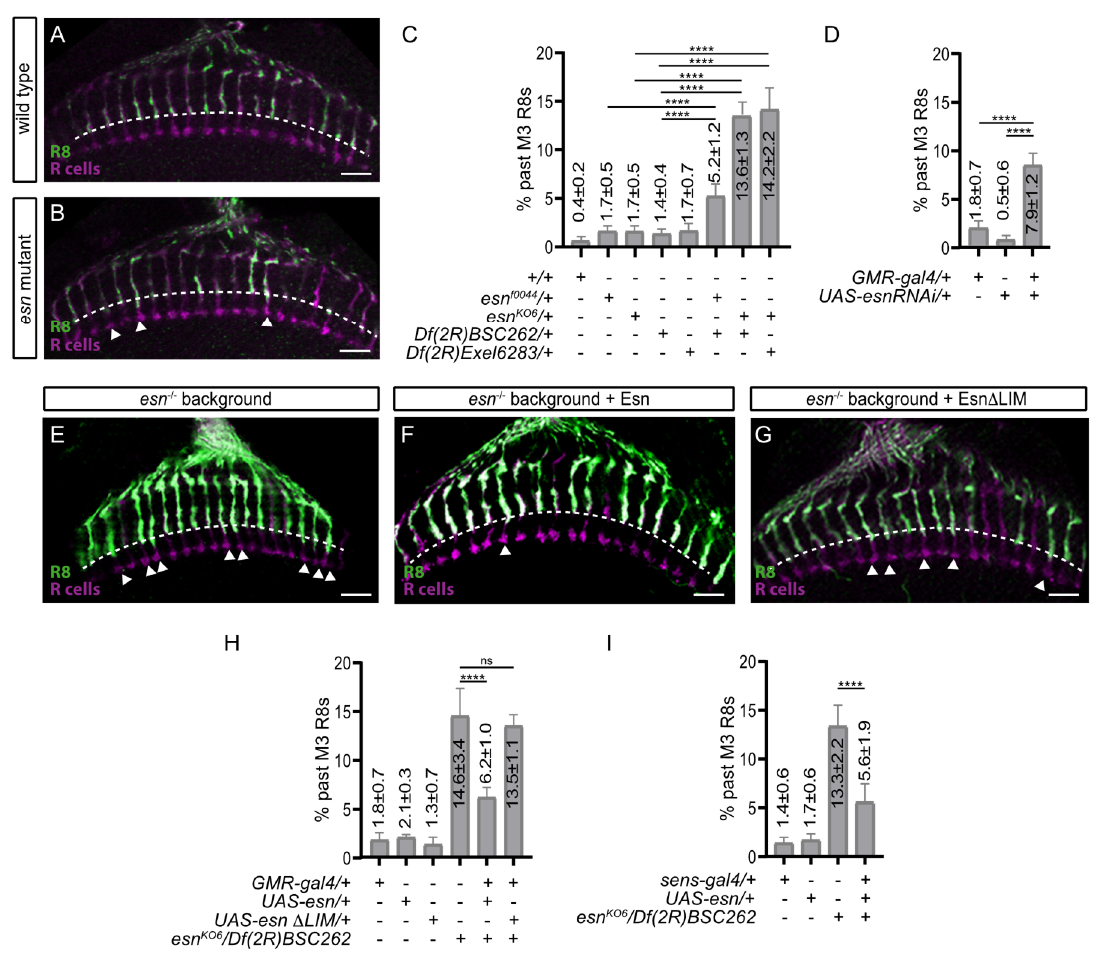
Figure 2. esn requirement in R8 final layer selection. All images are confocal sections of adult optic lobes with all photoreceptor axons (magenta) labeled with anti-Chaoptin and R8 axons (green) labeled with anti-lacZ antibody against the R8 specific marker Rh6-lacZ . Arrowheads indicate columns where R8 axons extend past their final target layer, M3 (white dashed line). Graphs show quantification of phenotypes and the statistical significance of relevant comparisons. ( A ) In control animals R8 axons terminate in the M3 layer. ( B ) In esn mutant animals, R8 axons in several columns extend past the M3 layer. ( C ) Graph showing the percentage of mistargeted R8 axons that extend past the M3 layer for di ff erent control and mutant allelic combinations. ( D ) Graph showing the percentage of mistargeted R8 axons in all-photoreceptor ( GMR-gal4 ) specific RNAi esn knockdown. ( E – G ) Confocal sections of adult arrays in an all-photoreceptor specific rescue experiment: ( E ) mutant background, ( F ) rescue experiment with a full length esn construct, and ( G ) rescue experiment with an esn construct lacking the LIM domain. ( H ) Graph showing the quantification of mistargeted R8 axons in the all-photoreceptor specific rescue experiment. ( I ) Graph showing the quantification of an R8-specific ( sens-gal4 ) rescue experiment. **** p < 0.0001. Scale bars 10